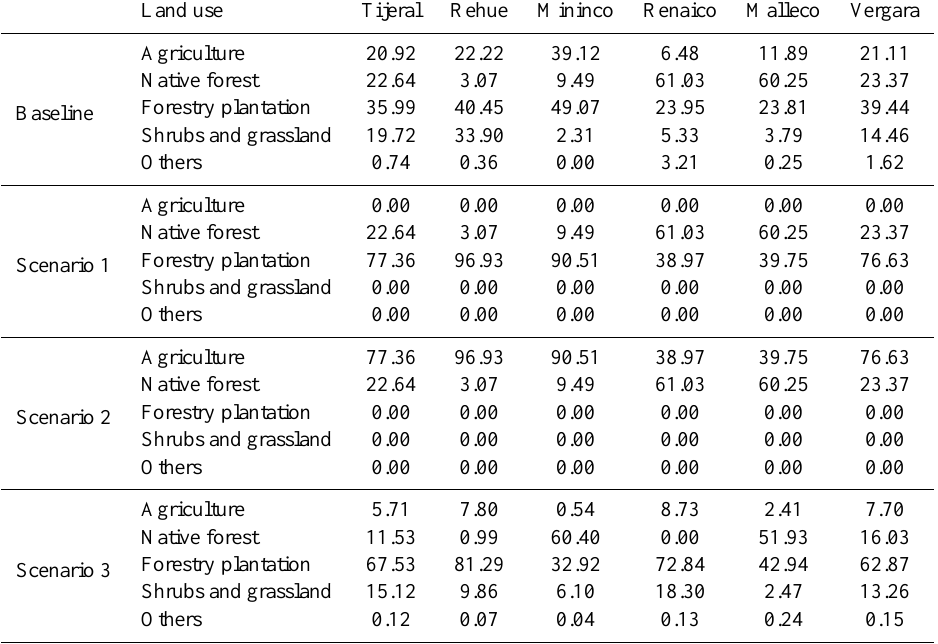
Table 12. Percentage of area covered by the different land uses for the Vergara watershed and its subbasins: Tijeral, Rehue, Mininco, Renaico and Malleco in baseline and scenarios 1, 2, and 3.